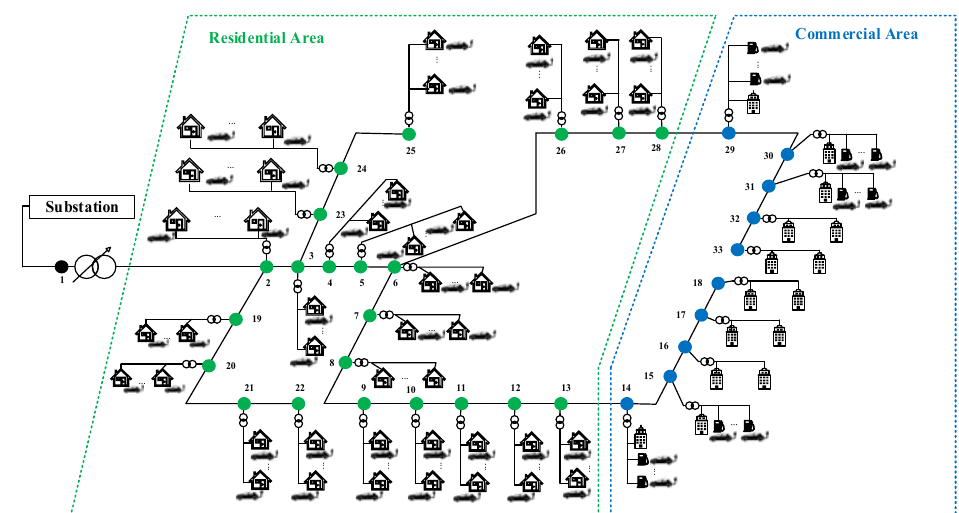
Figure 4. IEEE 33-bus system, connected with low-voltage residential and commercial feeders. (The numbers, 1–33, show the corresponding nodes).